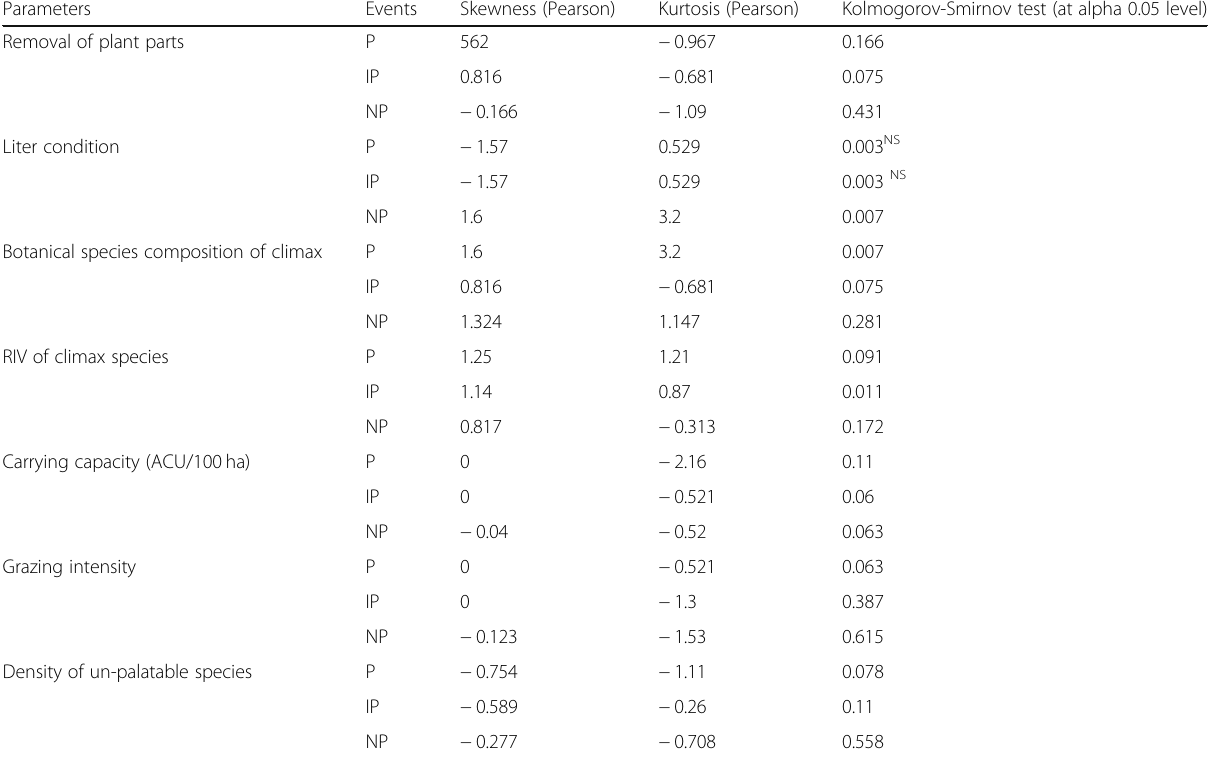
Table 4 Frequency parameters of different visual